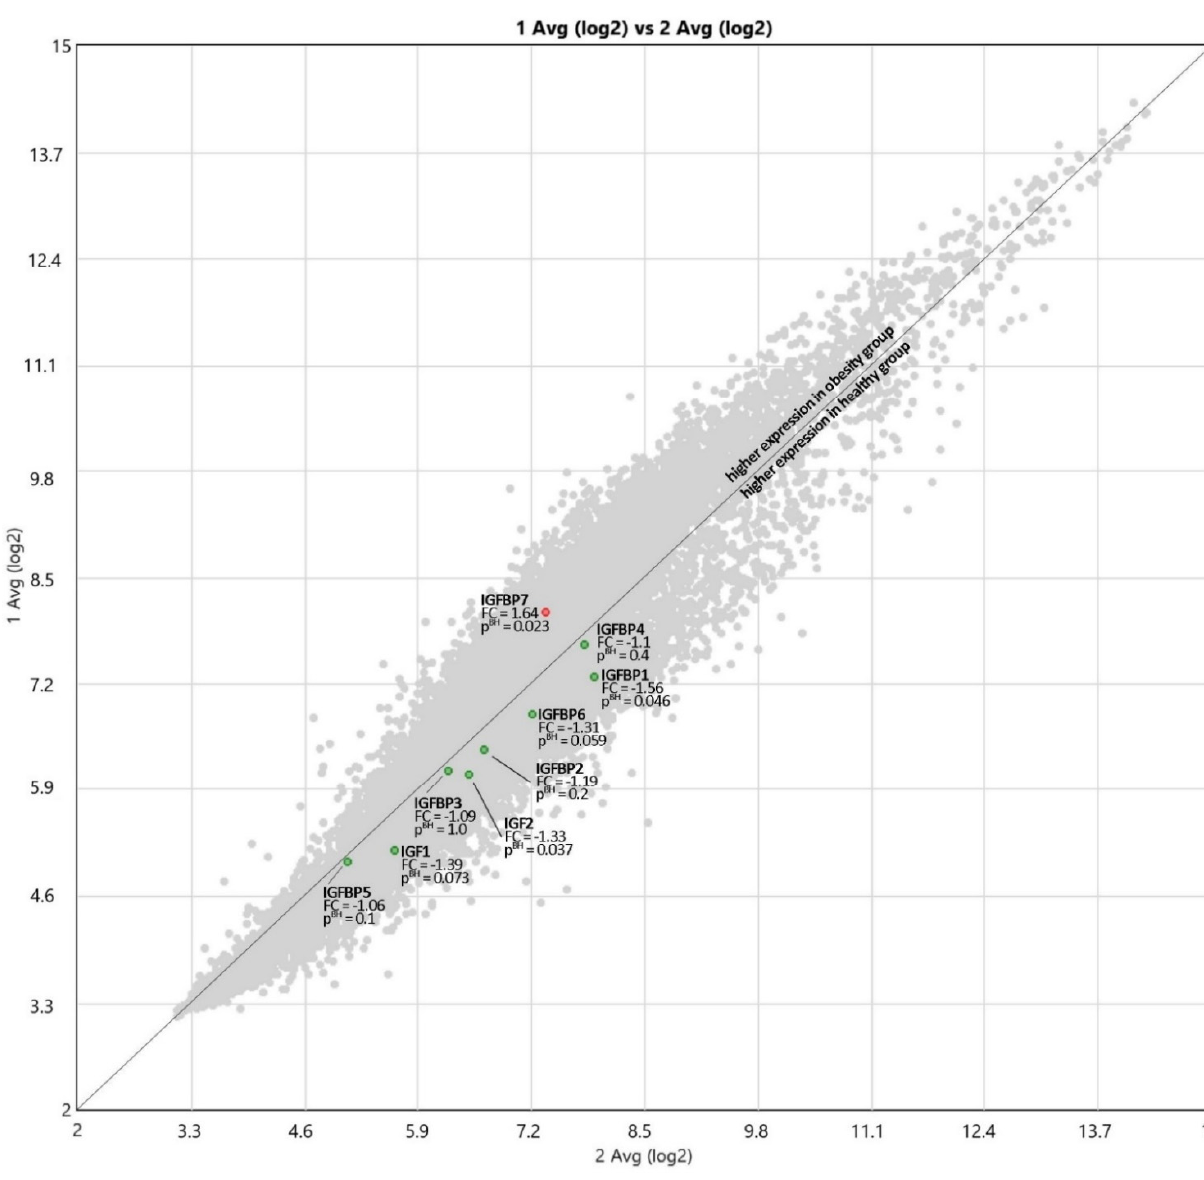
Figure 2. The expressions of IGF and IGFBP proteins’ genes; 1 Avg (log2)—OB, 2 Avg (log2)—HC, FC—Fold Change. Table 6. The expression values of IGF and IGFBP proteins’